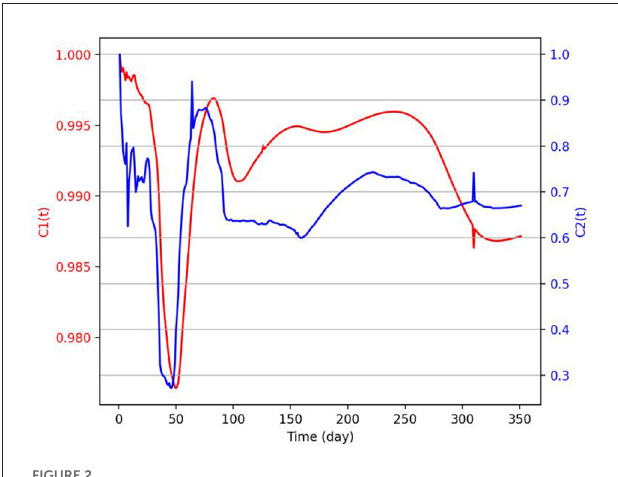
FIGURE2 Dynamic correlation coefficient c 1 ( t ) and c 2 ( t )